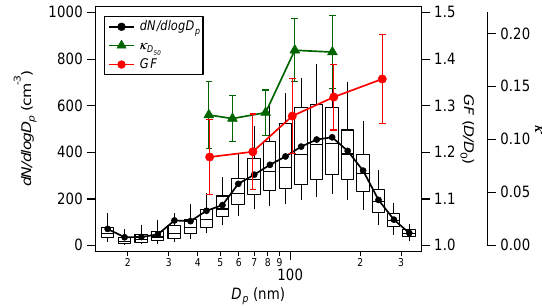
Figure 2. Particle number size distribution averaged over the en- tire measurement campaign. Box-and-whisker plots show the me- dian, interquartile ranges, and 5th and 95th percentiles, and lines and markers show mean d N/ dlog D p . Also shown are κ derived from the D 50 from the CCNc, and growth factor from the HTDMA, both as a function of particle diameter. Error bars represent ± 1 stan- dard deviation. Note that the HTDMA and CCNc/particle size data have been averaged over slightly different measurement periods, as shown in Figs. 4 and